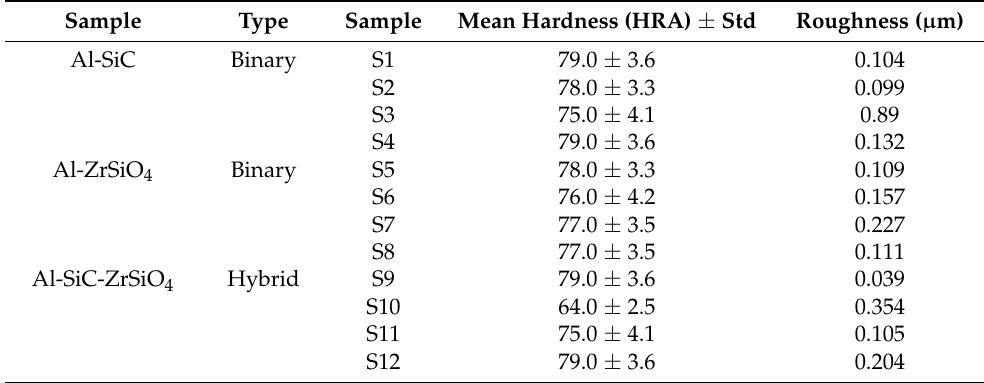
Table 3. Results of hardness and roughness.